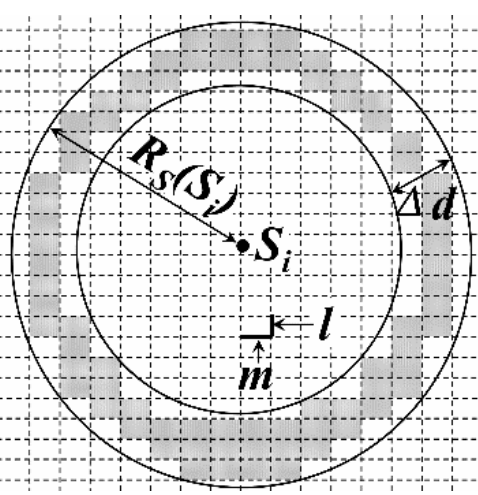
Figure 9. Sensing radius adjustment.